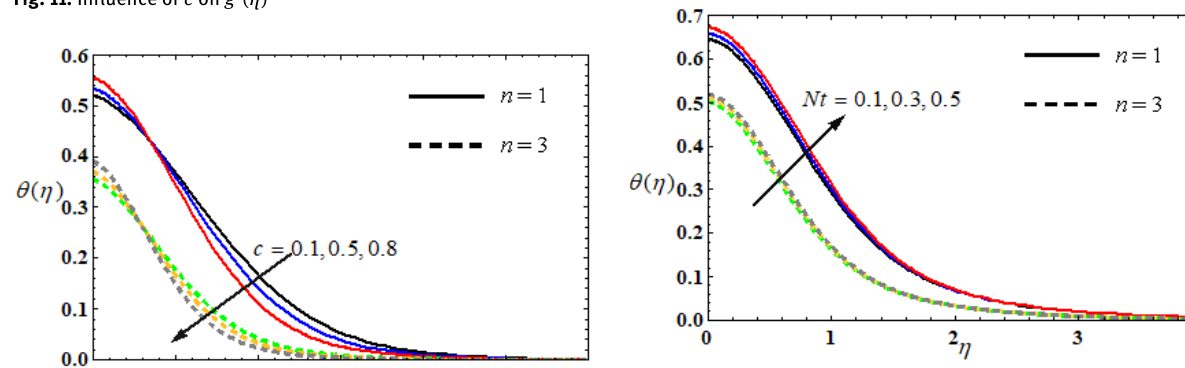
Fig. 15: Influence of Nt on θ ( η ) The effects of the Brownian motion parameter Nb on the temperature and nanoparticle volume fraction are shown in Figures 17–18, respectively. It is observed that the temperature of the fluid increases, while the concentra- tion of the fluid decreases with an increase in the values of Nb . Physically, the Brownian motion of particles is sim- ply the result of all the impulses of the fluid molecules on the surface of the particles. The fluid molecules have sig- nificantly high velocities and these velocities depend on the temperature of the fluid. The molecular velocities